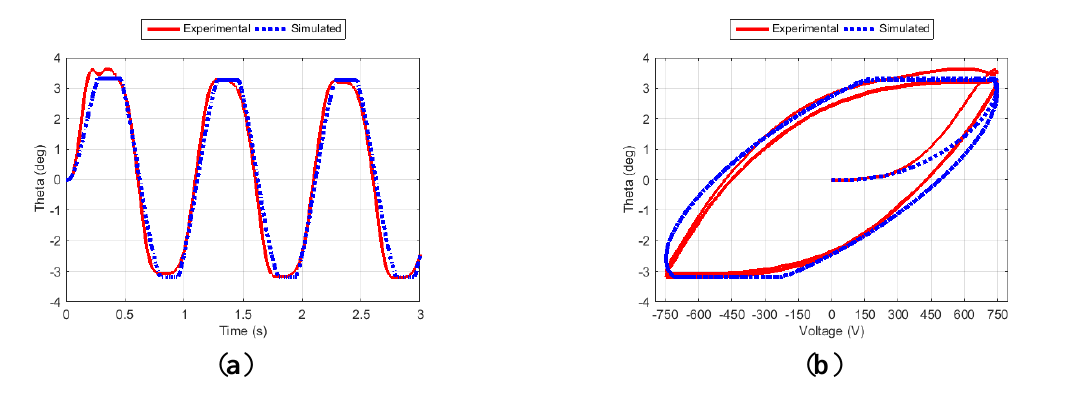
Figure 14. Fin angle ( a ) and hysteresis curve ( b ) for Case 9.